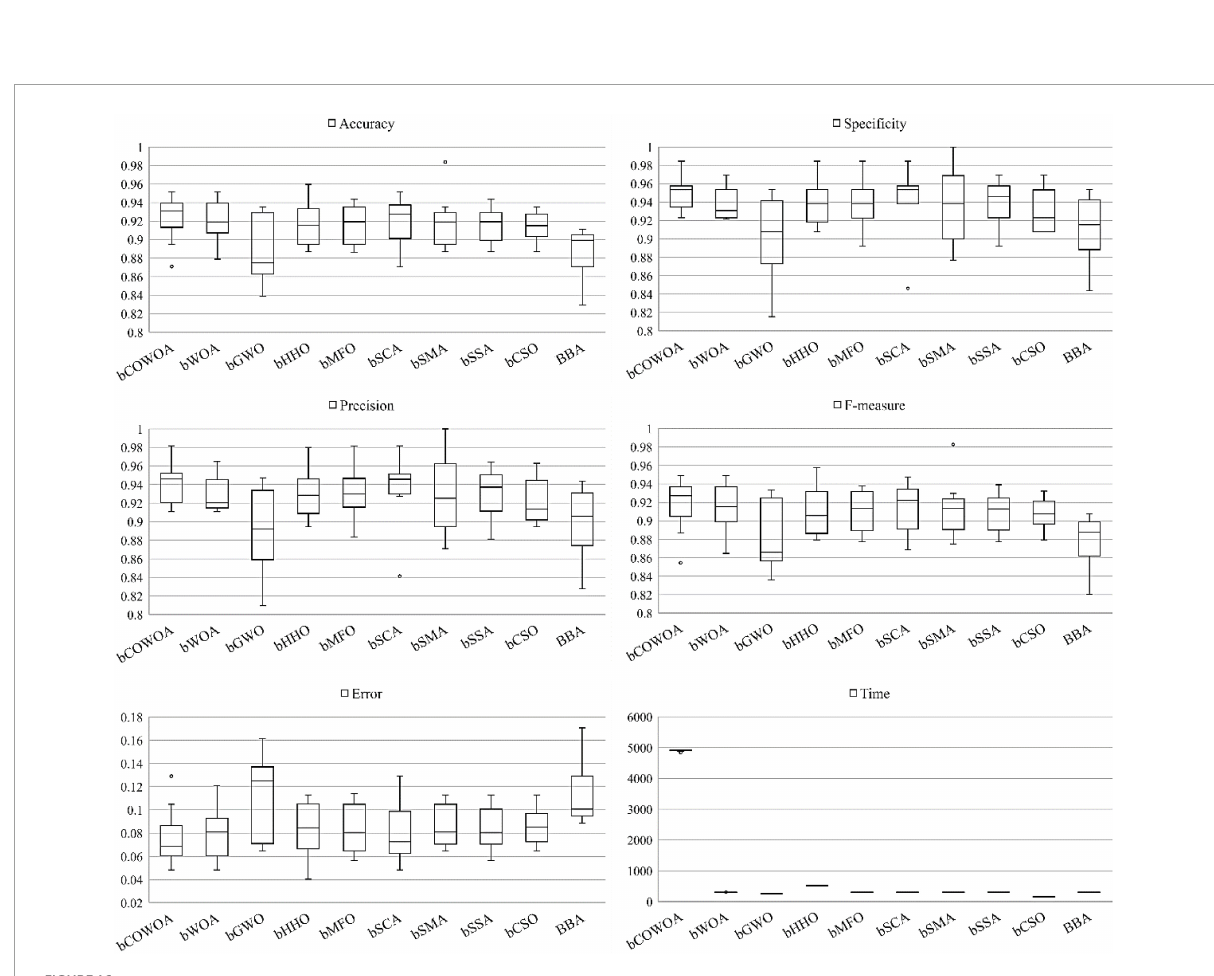
FIGURE16 Comparison results of bCOWOA with other binary